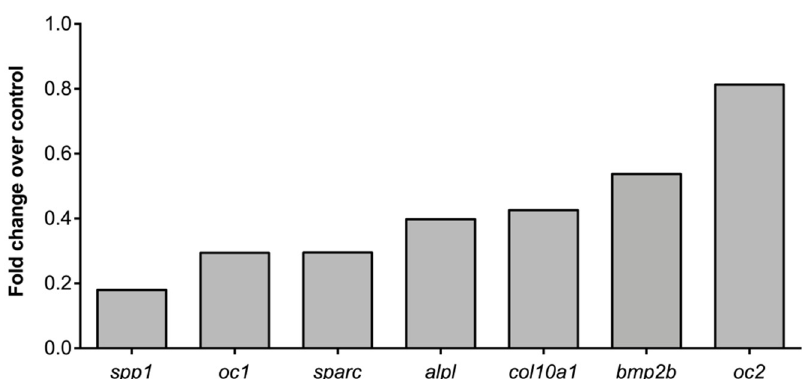
Figure 4. Gene expression in zebrafish post-larvae exposed for 20 days to 1 µ g/L of cadmium chloride. spp1 , osteopontin; oc1 , osteocalcin 1; sparc , osteonectin; alpl , alkaline phosphatase liver/bone/kidney; col10a1 , collagen type X alpha 1 chain; bmp2b , bone morphogenetic protein 2b; oc2 , osteocalcin 2. Values are presented as fold change over control (expression in larvae exposed to vehicle; set to 1 for all genes) and are the mean of 3 technical replicates performed in pools of more than 25